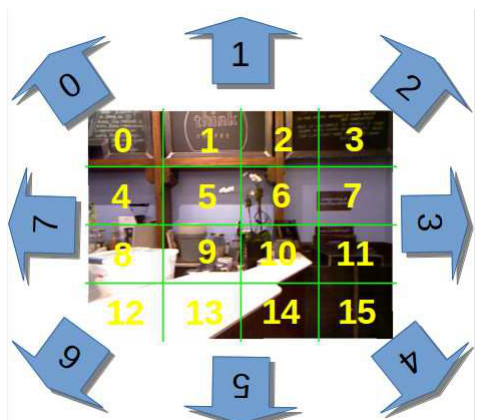
Figure 6. The image is divided equally into 16 cells and the eight-neighbourhood direction of the